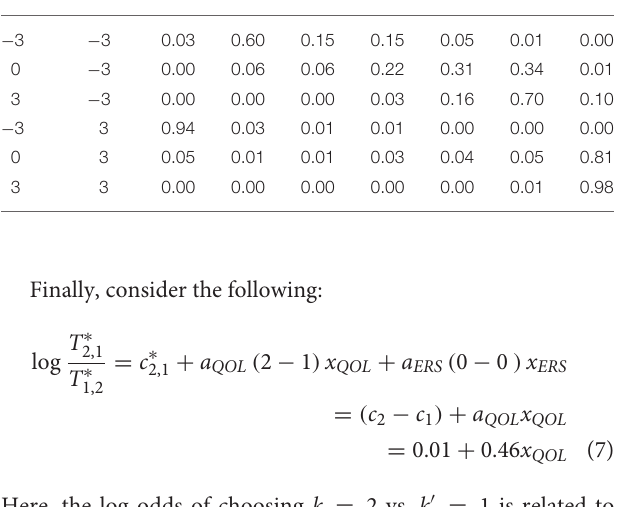
TABLE 3 | Probability of response in each category at several values of the latent traits. Latent Traits Probability of Response, T ( k | x )